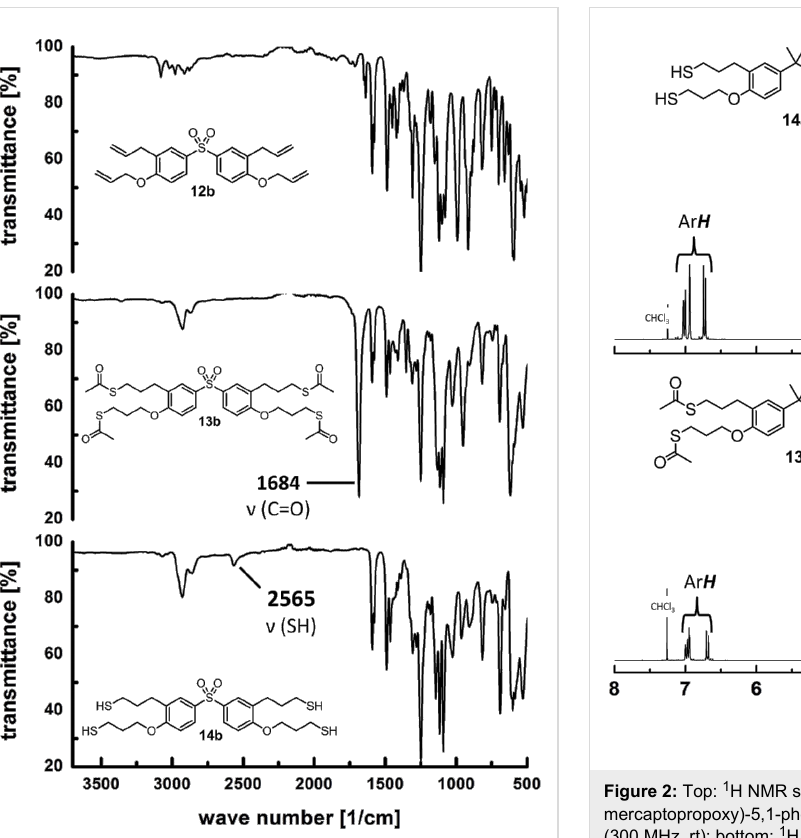
Figure 1: FTIR spectra of compounds 12b , 13b and 14b .